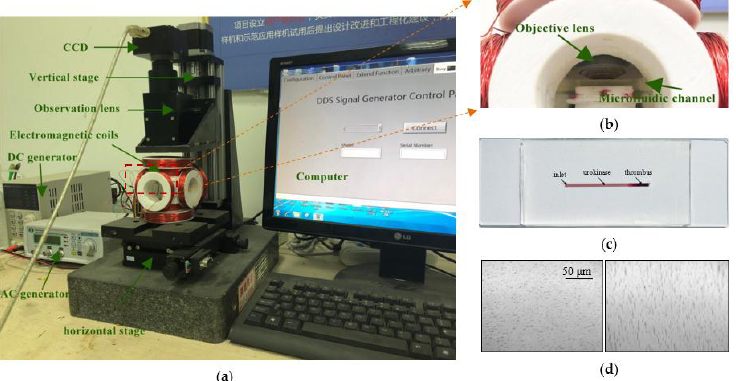
Figure 3. ( a ) Magnetic control and optical inspection system; ( b ) Microfluidic channel imaging setup; ( c ) Picture of the prepared thrombus-occluded channel; ( d ) Two images of NP aggregates in the microfluidic channel.